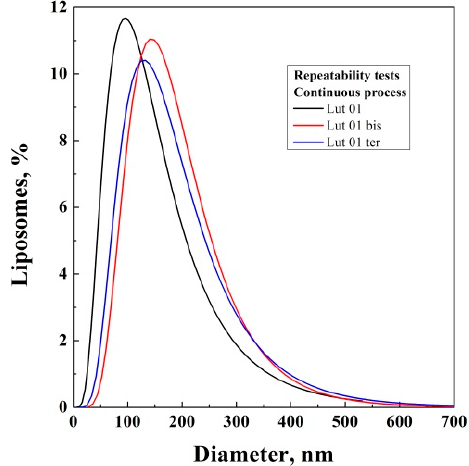
Figure 2. Particle size distribution obtained in repeatability